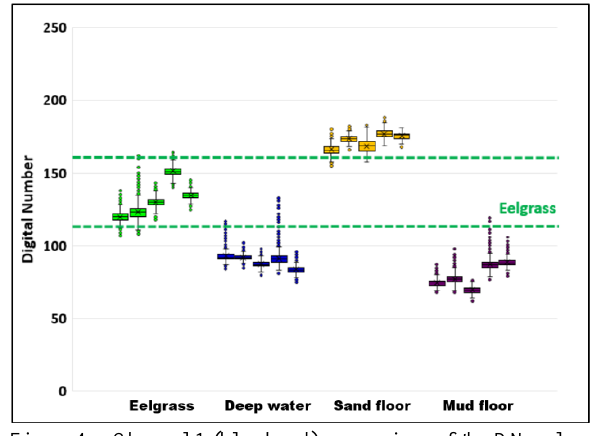
Figure 4: Channel 1 (blue band) comparison of the DN values for the four classes in the Pix4D RGB mosaic of Shediac Bay. The green dashes indicate the range of DN values that correspond to eelgrass.